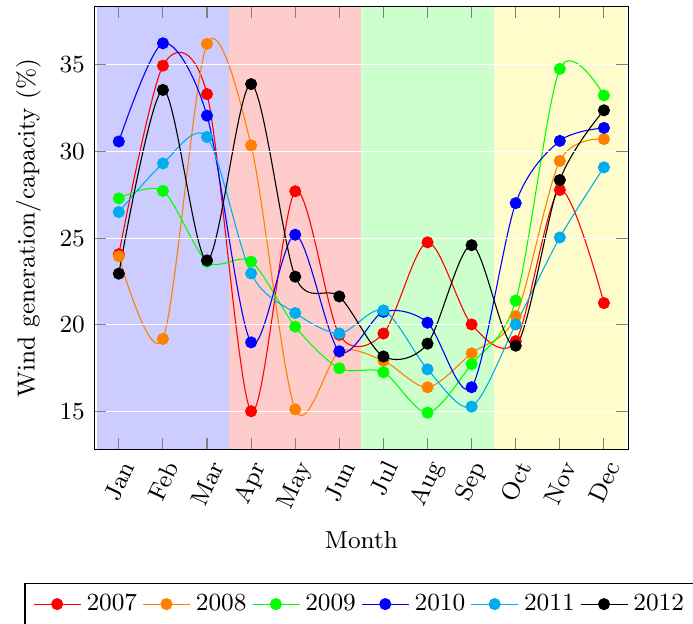
Figure 2. Aggregated wind power generation (Spanish power system, 2007–2012)